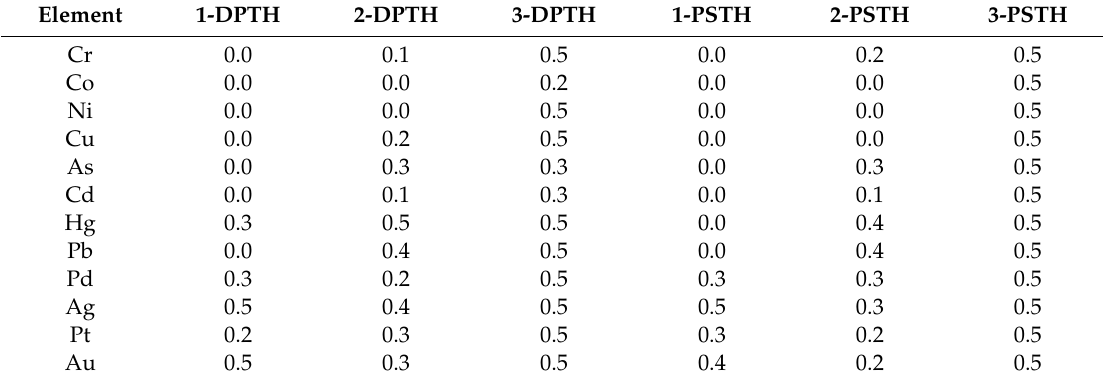
Table 4. Capacity of adsorption of the synthesized materials at acid pH (mg / g).